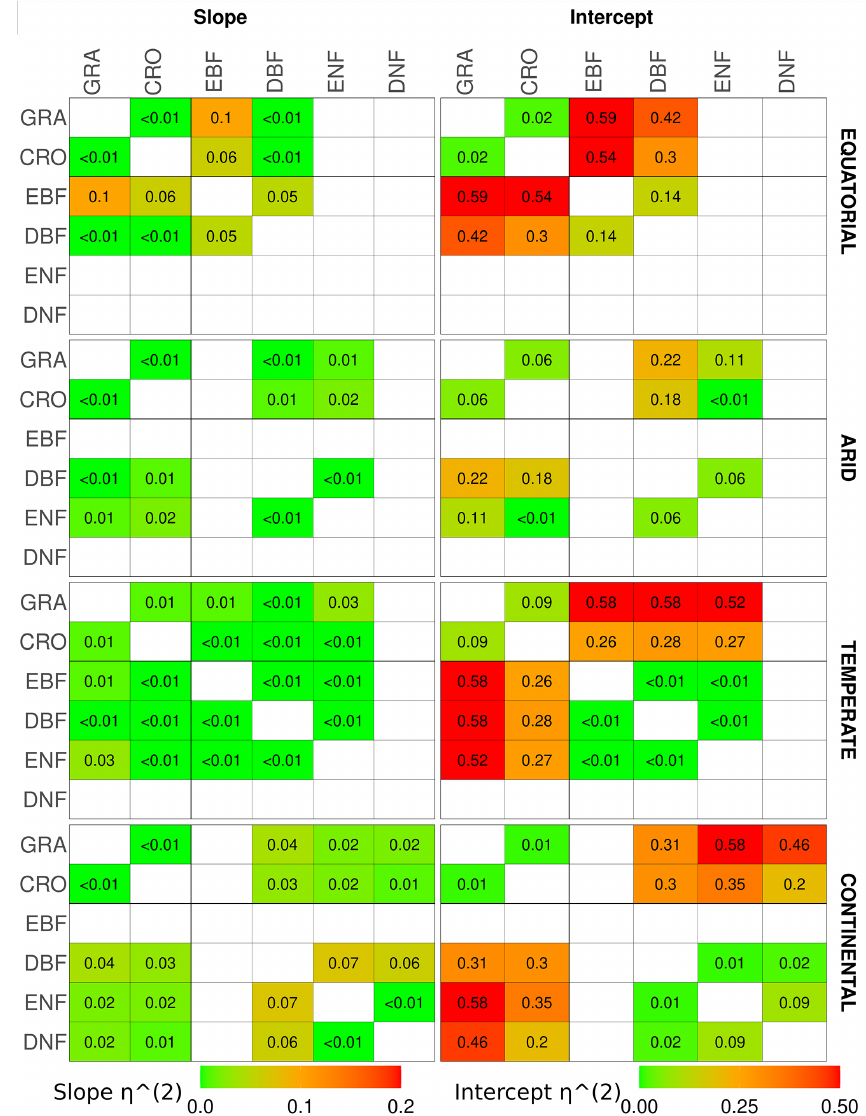
Figure A8. The η 2 parameter of an analysis of covariance between pairs of vegetation covers in different Köppen–Geiger climate groupings, for the slope (left) and intercept (right) of the linear relationship between TROPOMI SIF and FLUXCOM GPP. ANCOVA is performed on the intercept under the assumption that the difference between slopes is not significant. The η 2 parameter is comparable to the percentage of the difference in the slope or intercept (the latter assuming equivalence of the slopes) attributable to the difference in vegetation cover, with lower values signifying a smaller difference between vegetation covers. A slightly bolder line is used to separate the herbaceous species (CRO, GRA) from the woody species (EBF, DBF, ENF,